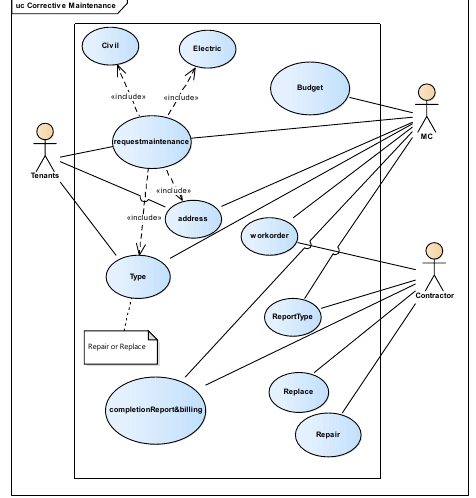
Figure 5. Use Case Diagram for Corrective